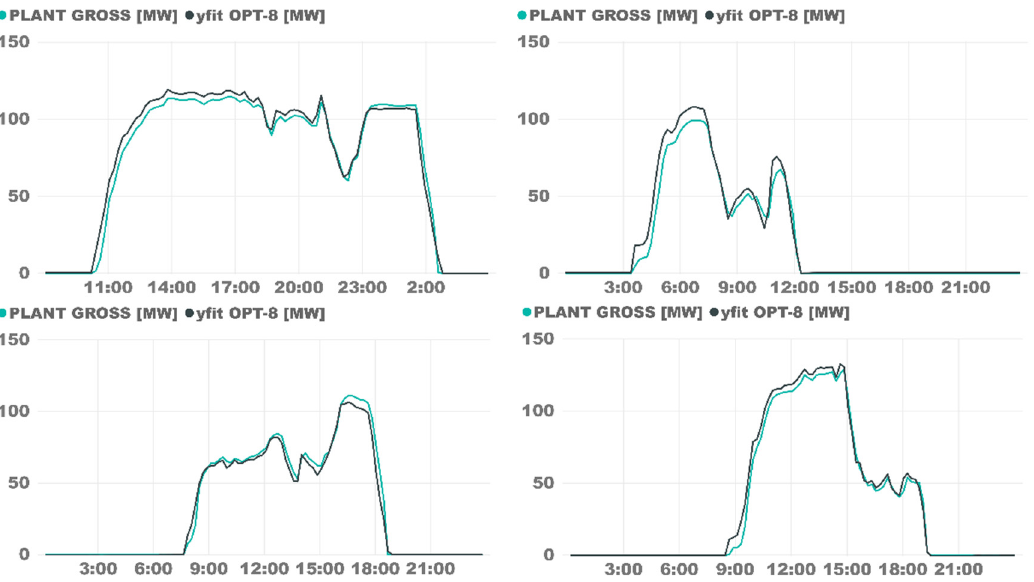
Figure 8. OPT-8 plant B model validation on specific days.